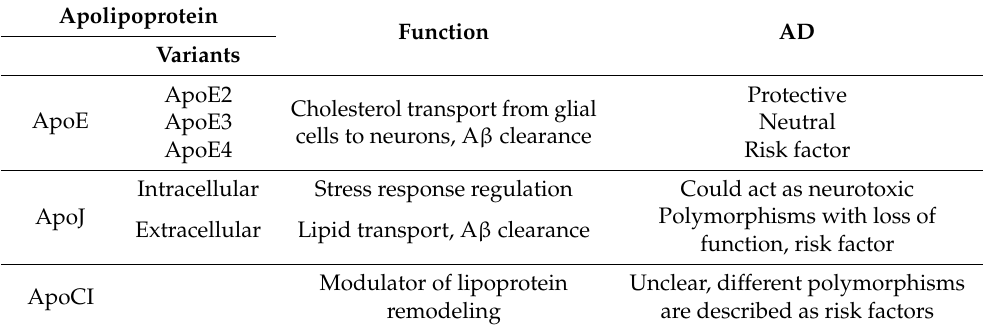
Table 1. Apolipoprotein function and relationship with AD. Apolipoprotein Function AD Variants ApoE2 Protective Cholesterol transport from glial ApoE ApoE3 Neutral cells to neurons, A β clearance ApoE4 Risk factor Intracellular Stress response regulation Could act as neurotoxic Polymorphisms with loss of ApoJ Extracellular Lipid transport, A β clearance function, risk factor Modulator of lipoprotein Unclear, different ApoCI remodeling